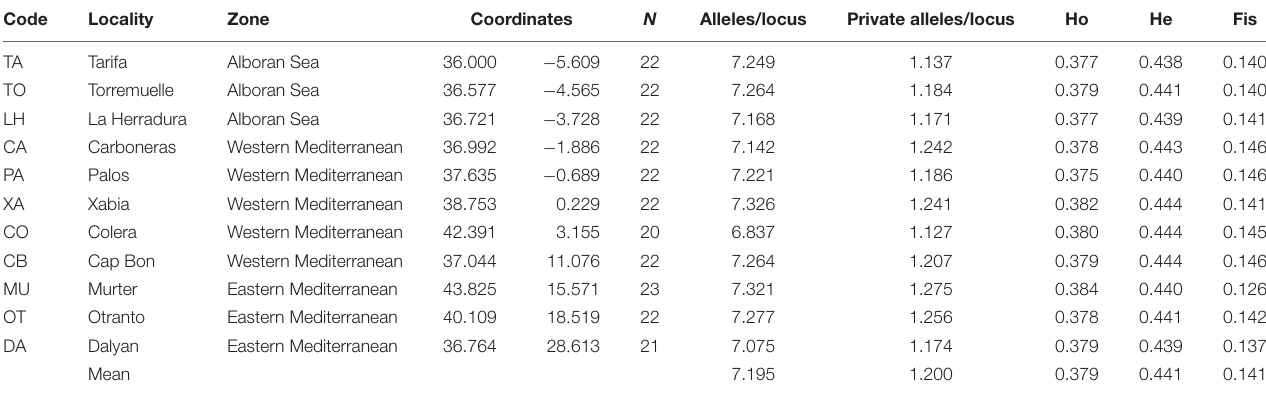
TABLE 1 | Geographic location and main genetic features of the populations studied. All Fis values were significant (after FDR